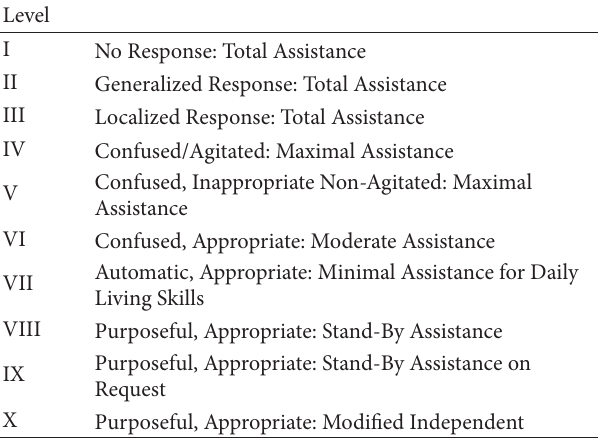
Table 1: Rancho Los Amigos Cognitive Scale-Revised, levels of cognitive functioning